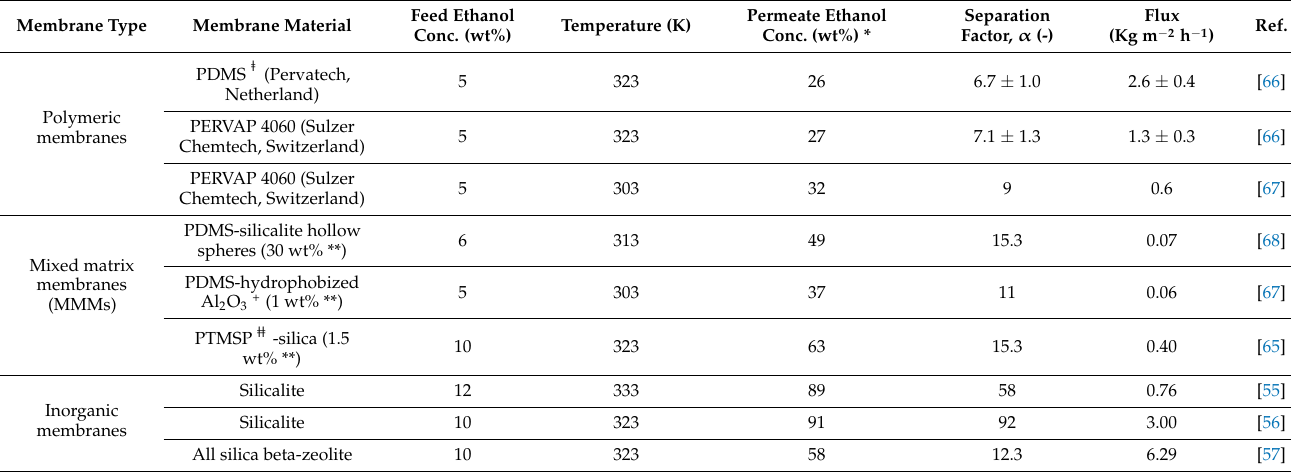
Table 2. Examples of ethanol-selective